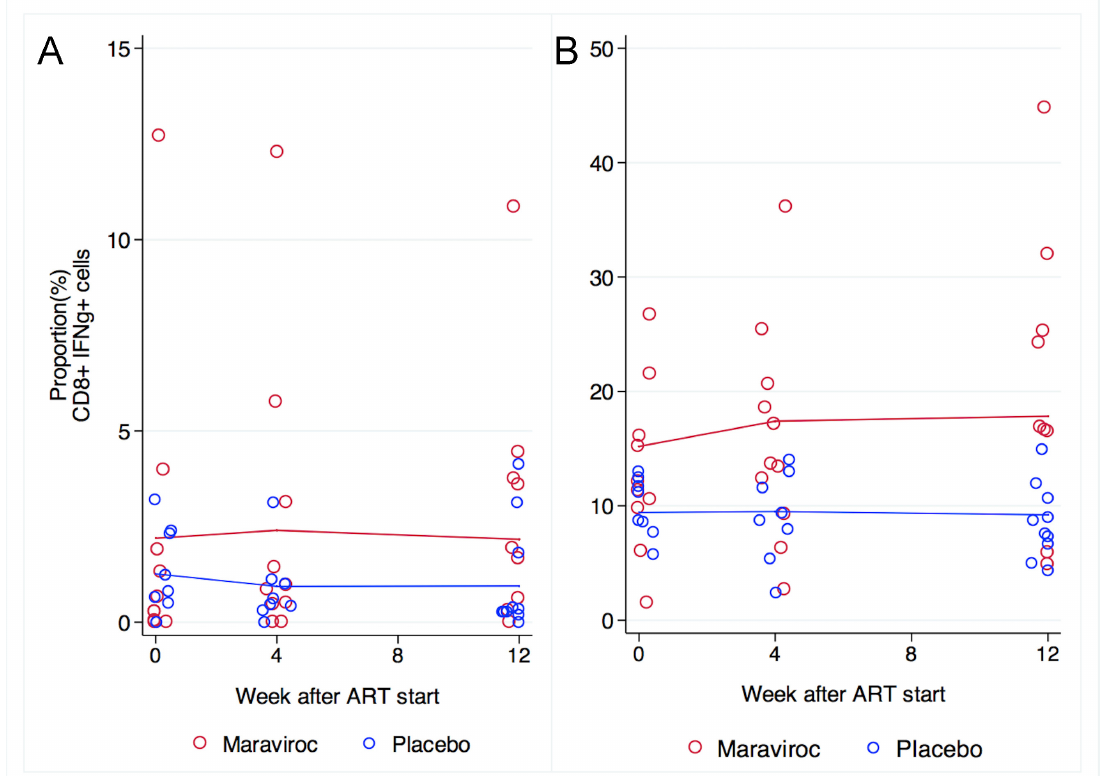
Supplementary Figure 4. Proportion of CD8 lymphocytes expressing IFNg upon exposure to CMV peptides and